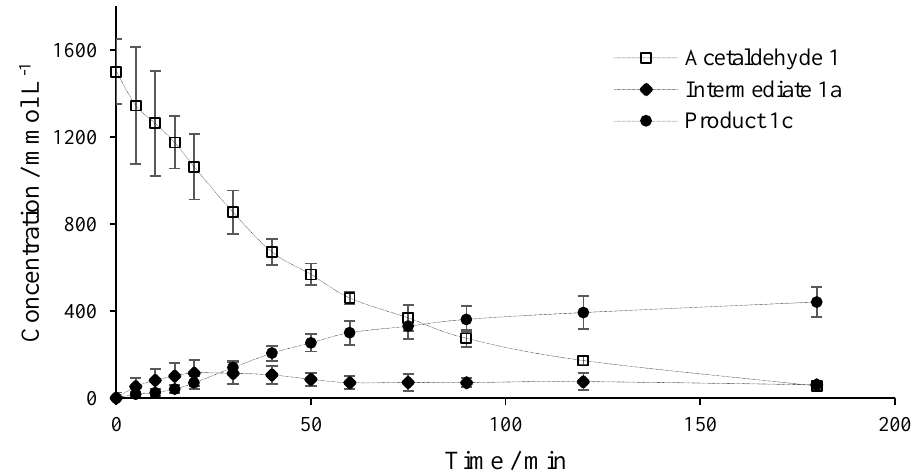
Figure 7. Time course of conversion of acetaldehyde 1 with DERA to the dimer 1a , and subsequently to the lactol 1c , at the optimized reaction conditions (32 °C, pH 7.5) based on the DoE, 5 mL of final volume, 0.1 M of TEOA buffer, 1.5 M of substrate concentration, 70 µL of DMSO, and 100 mg of DERA in freeze-dried E. coli cells.